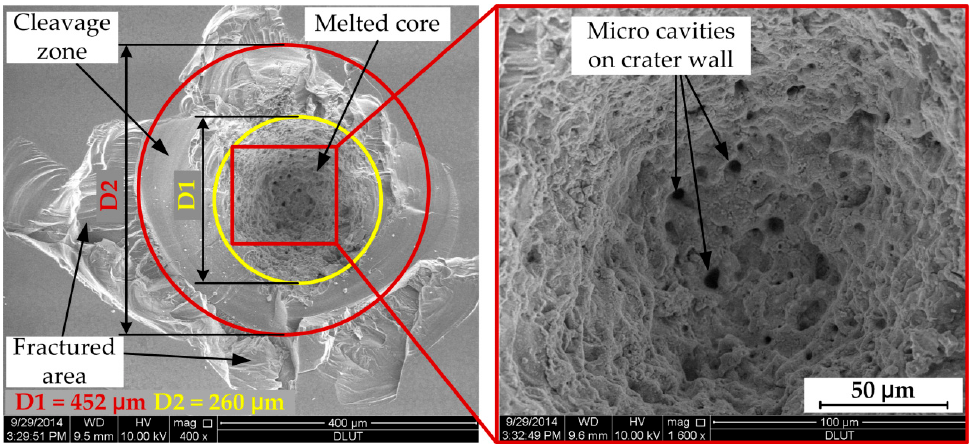
Figure 8. Typical appearance of damage morphology on processed KDP surface.